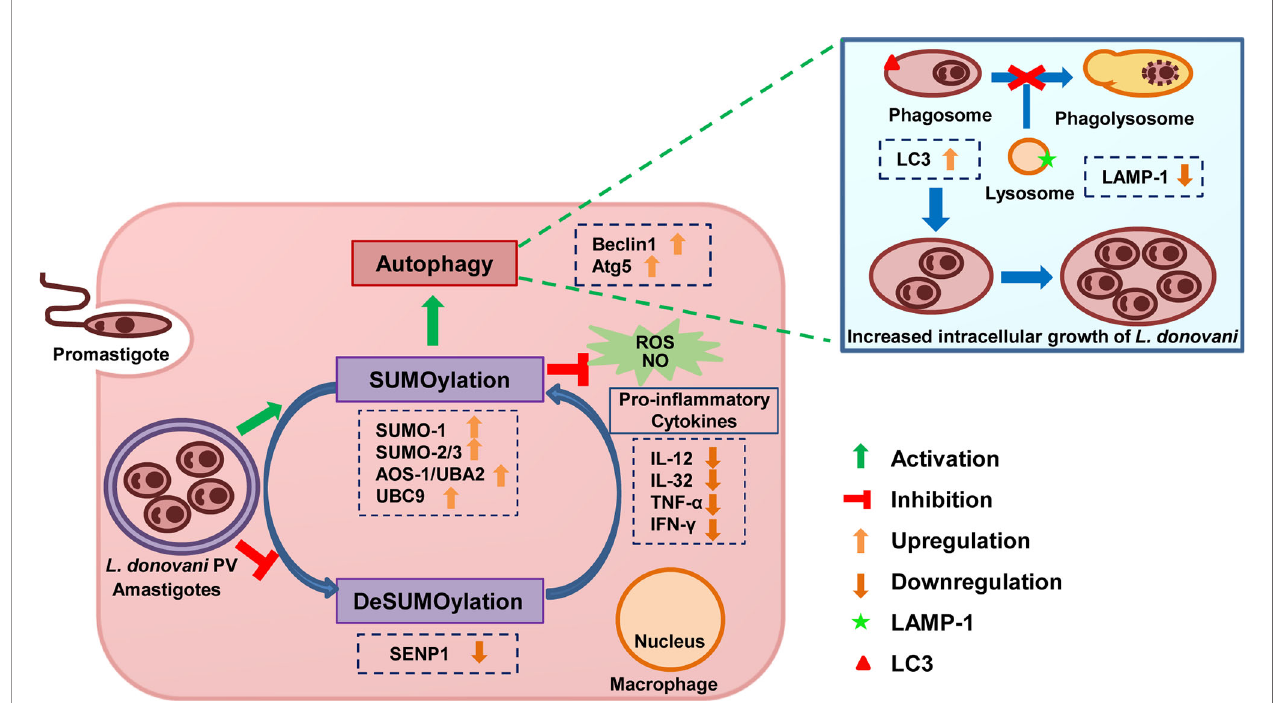
FIGURE 7 | Schematic representation of Leishmania donovani survival and growth in the macrophages regulated by the host SUMOylation pathway. Host SUMOylation promotes autophagy initiation while suppressing autophagy maturation, ROS generation, and nitric oxide production as well the secretion of pro-in fl ammatory cytokines, thus favoring the parasite growth and survival. Targeting this pathway could be a potential target for developing novel drugs to restrict the parasite ’ s survival and growth. ROS, reactive oxygen